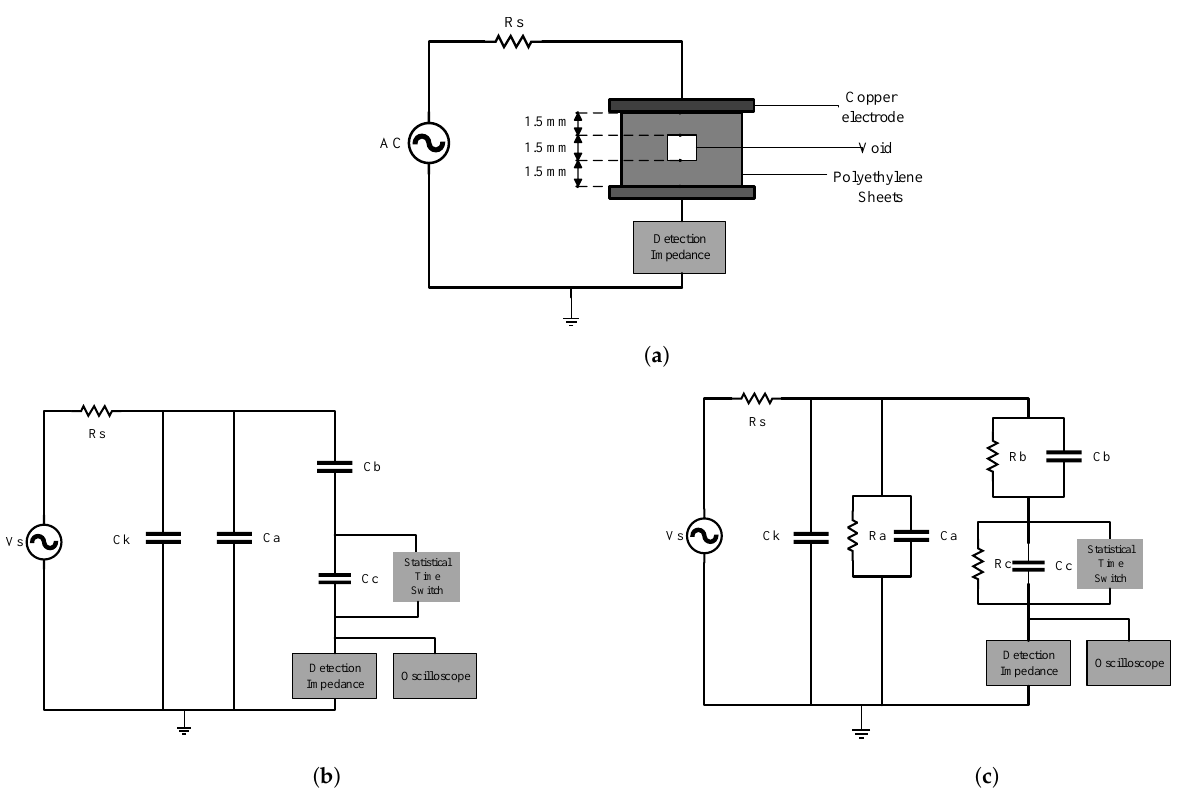
Figure 1. Equivalent circuit of the PD detection system with the ABC model implemented in MATLAB ® Simulink ® . ( a ) schematic of test specimen; ( b ) capacitors only model; ( c ) capacitors with resistors model. Table 2. Parameter definition and values used for the ABC model simulated in MATLAB ® Simulink ® .